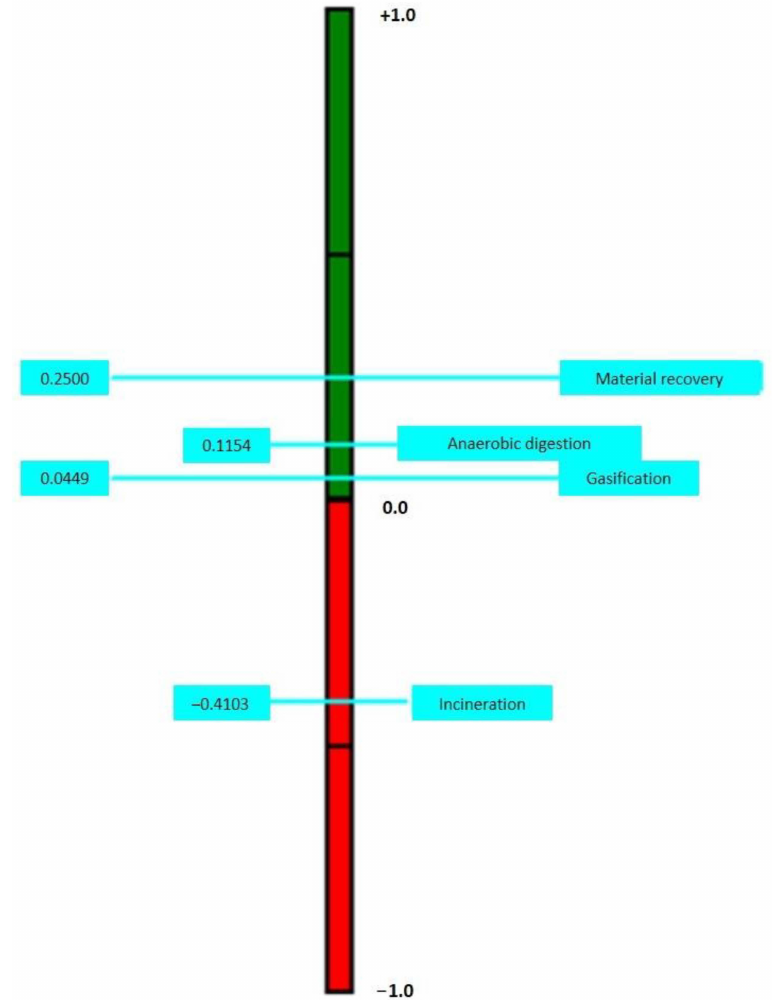
Figure 5. The PROMETHEE II complete ranking of sewage sludge treatment technologies. The impact of each criteria cluster on the final rankings is depicted using the PROMETHEE rainbow graphical representation in Figure 6. Each criteria cluster and criteria group is attributed a